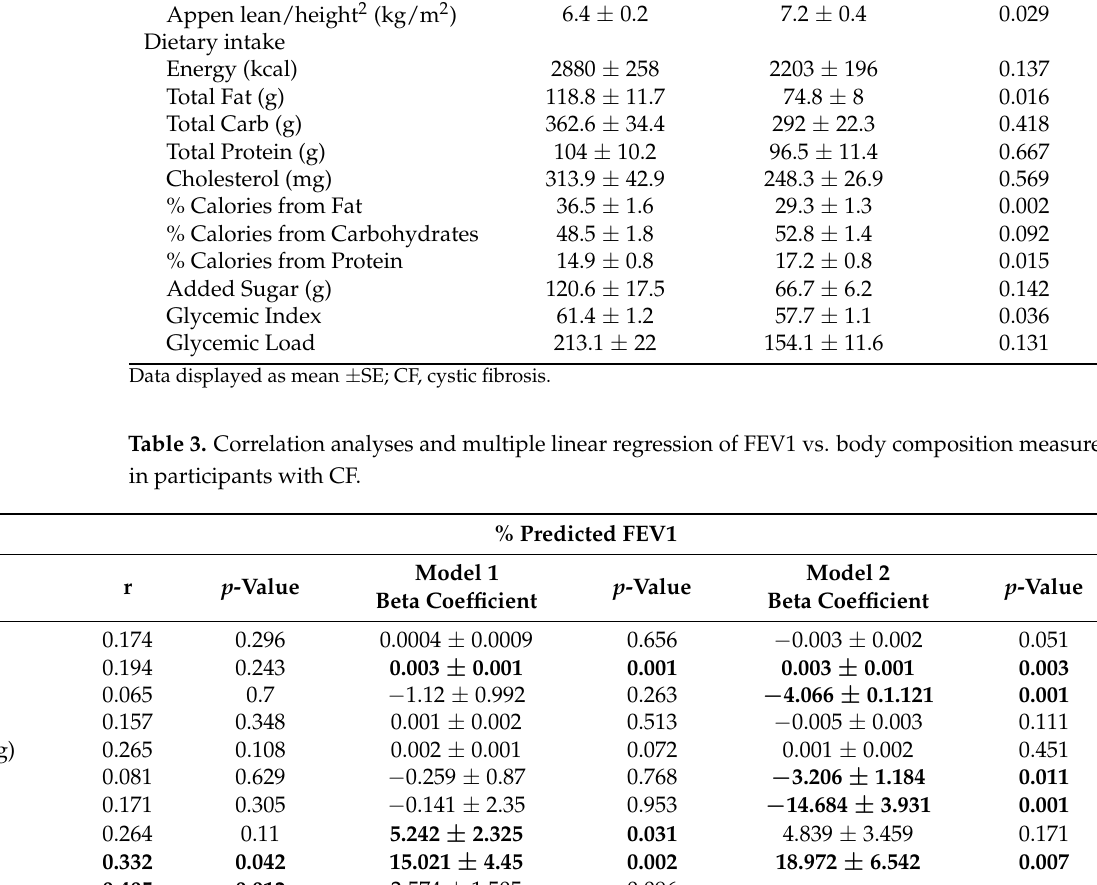
Table 4 outlines the results of the correlation analysis between DXA body composition measures, dietary intake components, and physical activity scores. Multiple measures of body fat composition, particularly fat mass, % fat, and FMI, negatively correlated with total amount of macronutrients (energy, fat, carbohydrate and protein), though the relative proportion of each macronutrient intake did not correlate with body composition. Added sugar and glycemic load both negatively correlated with multiple measures of body fat, including % fat and FMI. Lean mass, LMI, and ALMI were not significantly